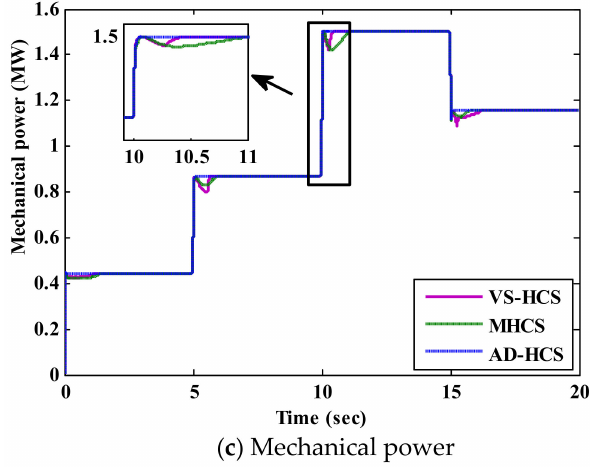
Figure 11. Comparative study of the proposed algorithm and current HCS algorithms. Table 2. Comparison between the current HCS techniques and the proposed AD-HCS